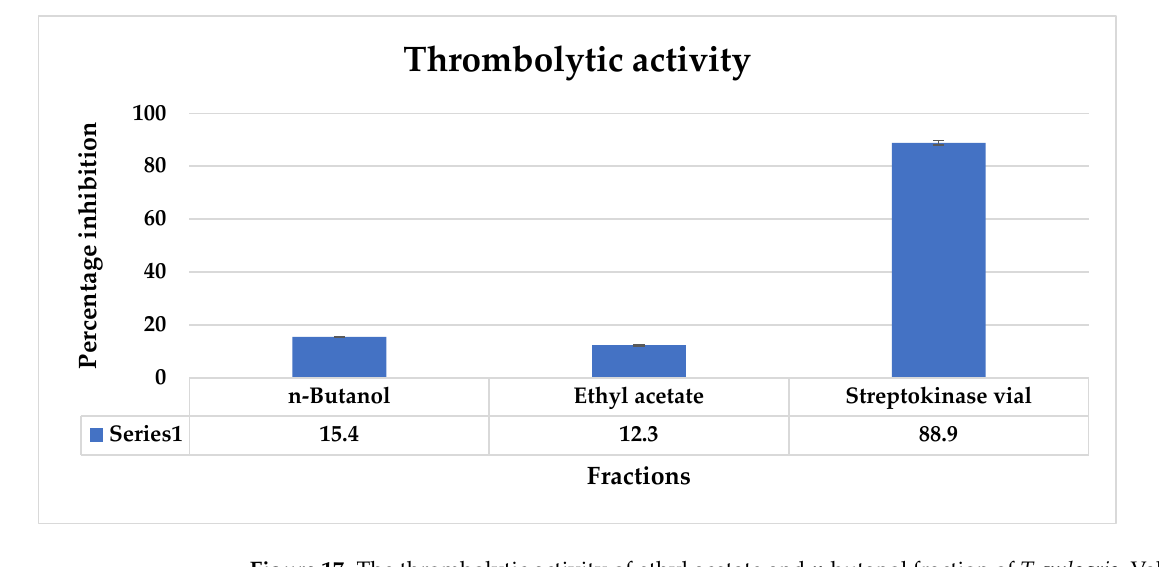
Figure 17. The thrombolytic activity of ethyl acetate and n- butanol fraction of T. vulgaris . Values are expressed in mean ± SD and all values are significant at p < 0.05.